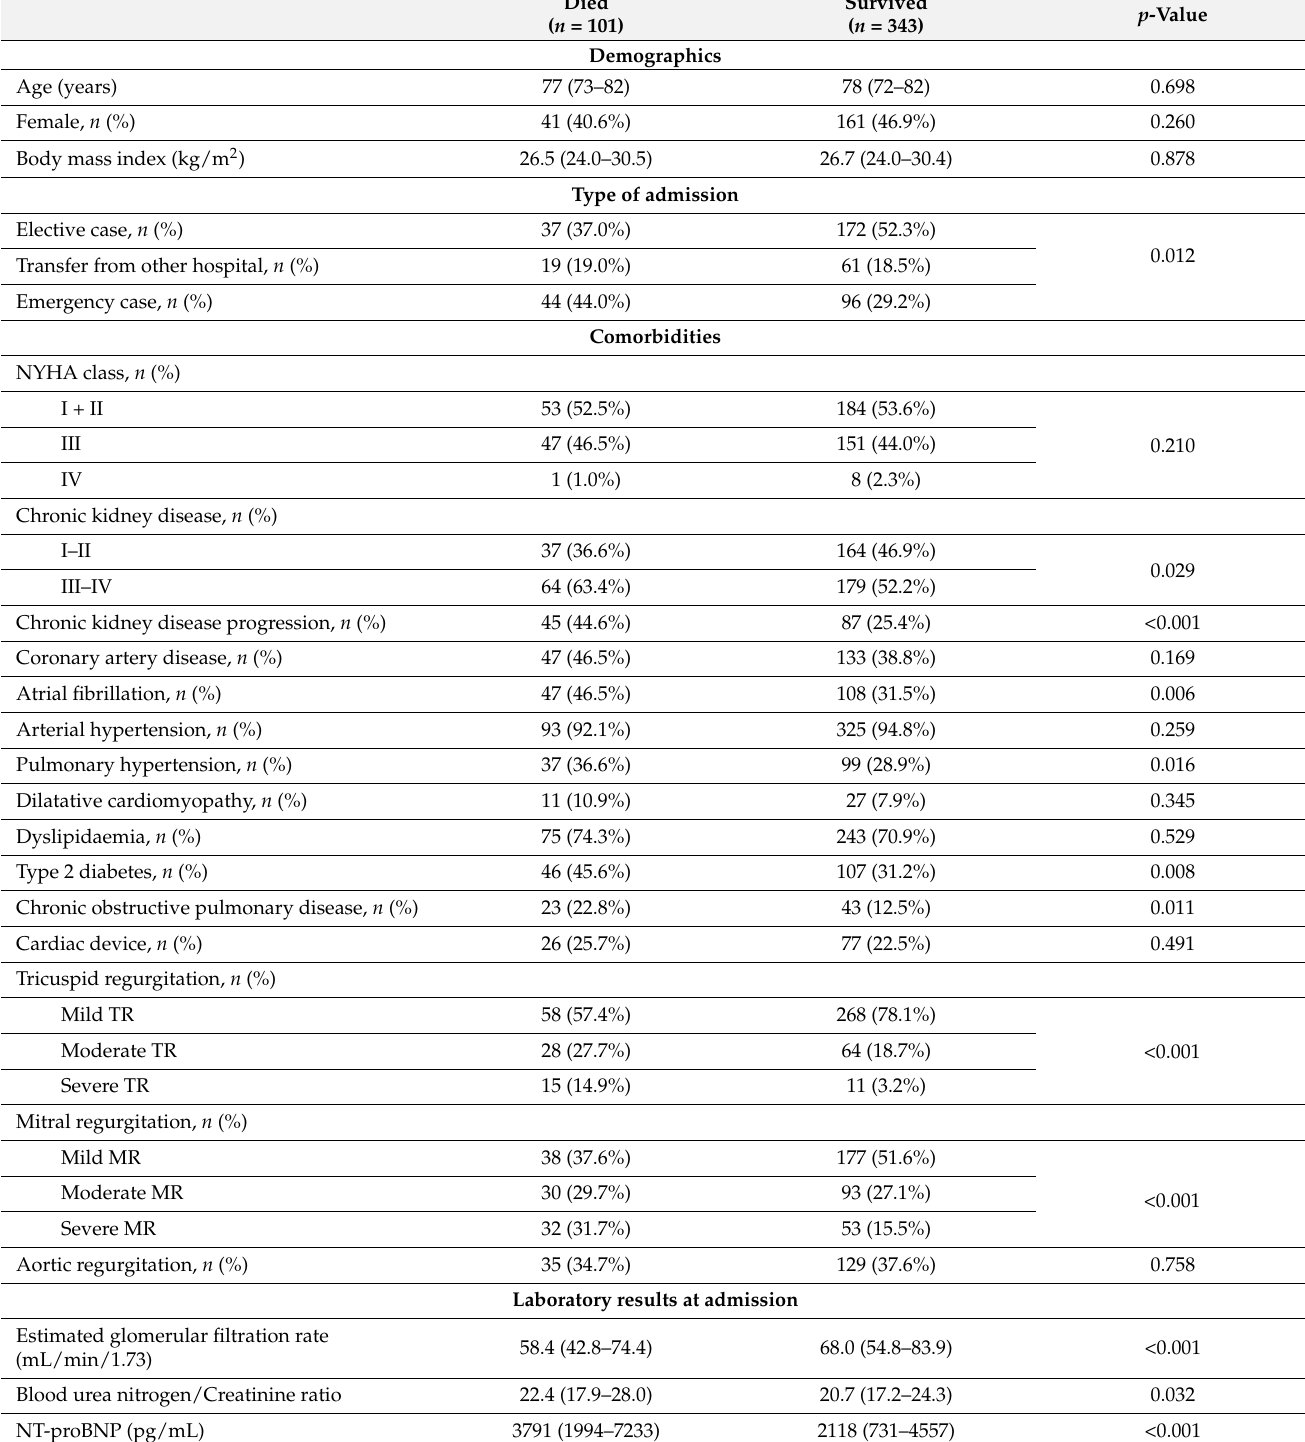
Table 1. Patient characteristics according to all-cause mortality